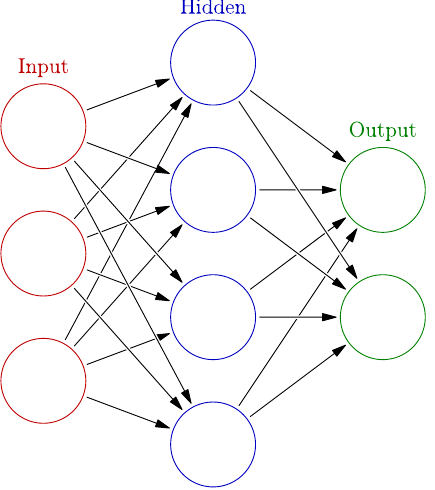
Figure 2. Example of ANNs, the number of input neurons determines the number of features considered in the network, every neuron is connected by a weight and will determine the output layer’s